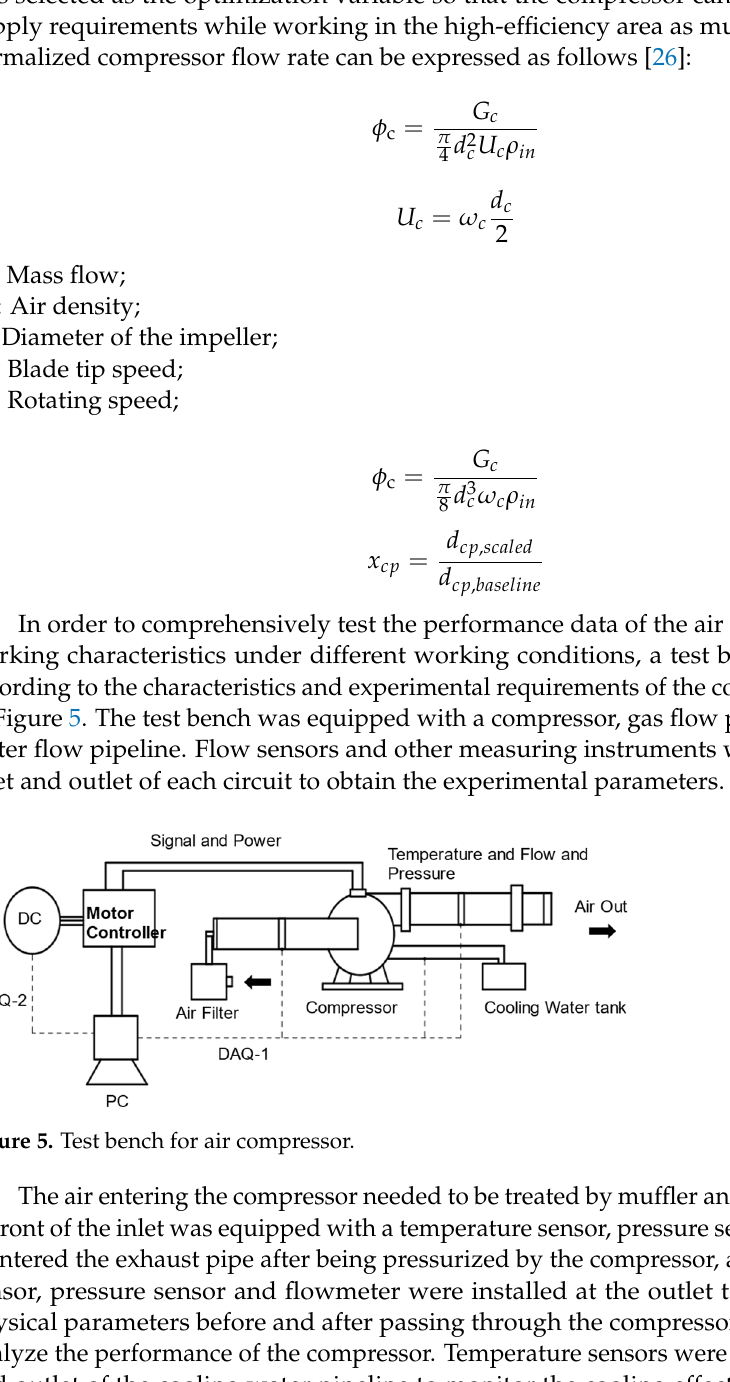
Figure 6. Efficiency–flow curve of the air compressor. In Figure 7, it can be seen that there was a close relationship between the pressure and flow at a particular working speed, and a change in the outlet pressure could result in a large change in mass flow. The compressor could provide a larger gas mass flow, and the working speed was the main factor in determining pressure and flow. The left area of the characteristic curve is the surge area. At this boundary, the mass flow is small and the 10